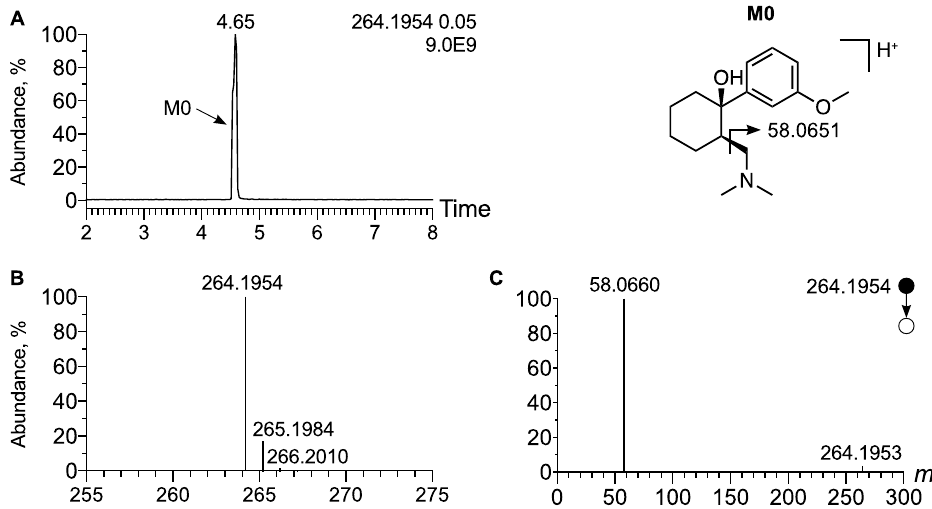
Figure 1. Analytical features of tramadol. ( A ) Extracted ion chromatogram of urine extract at m / z 264.1954 corresponding to [M + H] + ion of tramadol. ( B ) Mass spectra of tramadol and its corresponding isotopic pattern. ( C ) MS/MS spectra of [M + H] + ion of tramadol. Inspection of the MS/MS spectra allow for the identification of an intense peak at m / z 58.0660 corresponding to a methyl aziridium ion, indicative of the dimethyl amino radical of tramadol.